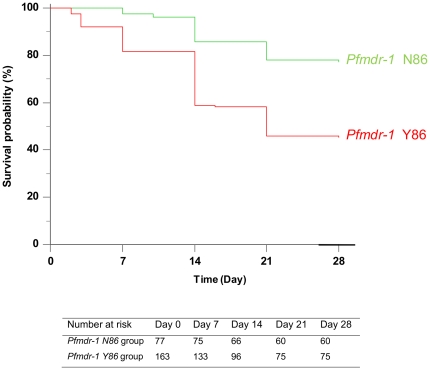
Curves of cumulative incidence of recurrence of patients over the 28-day follow-up period.Kaplan-Meier curves of cumulative incidence of recurrence of patients over the 28-day follow-up period according Pfmdr-1 mutation at position 86 in isolates of day of recurrence from patients included in the analysis, Madagascar in 2006–2007.